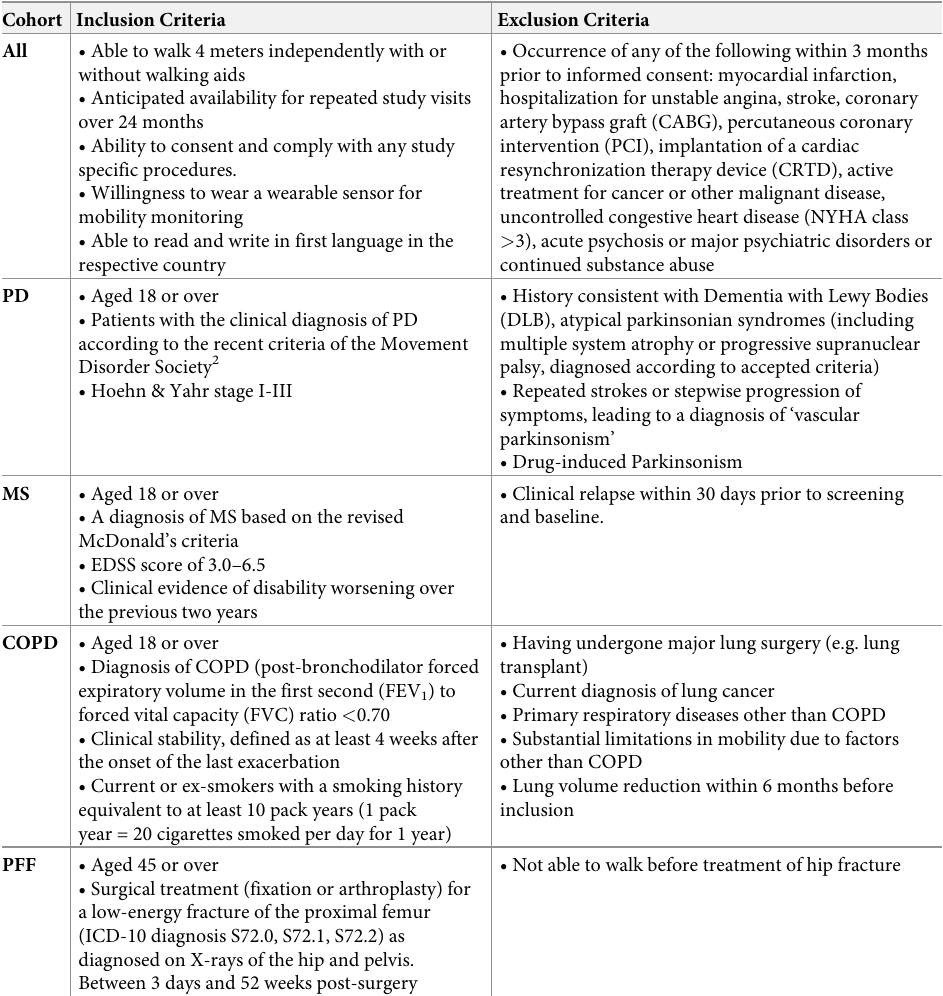
Table 1. Inclusion and exclusion